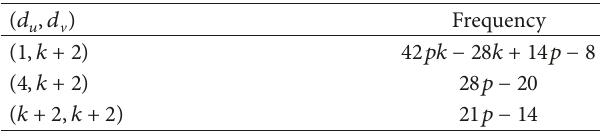
Table1:Edgepartitionof 𝐹 𝑝 basedondegreesofendverticesofeach